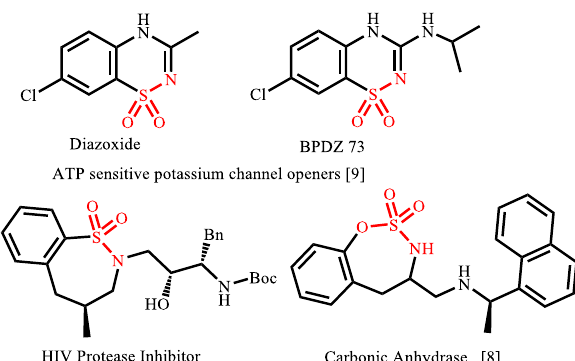
Figure 1. Examples of biorelevant compounds incorporating endocyclic sulfonamide fragment.